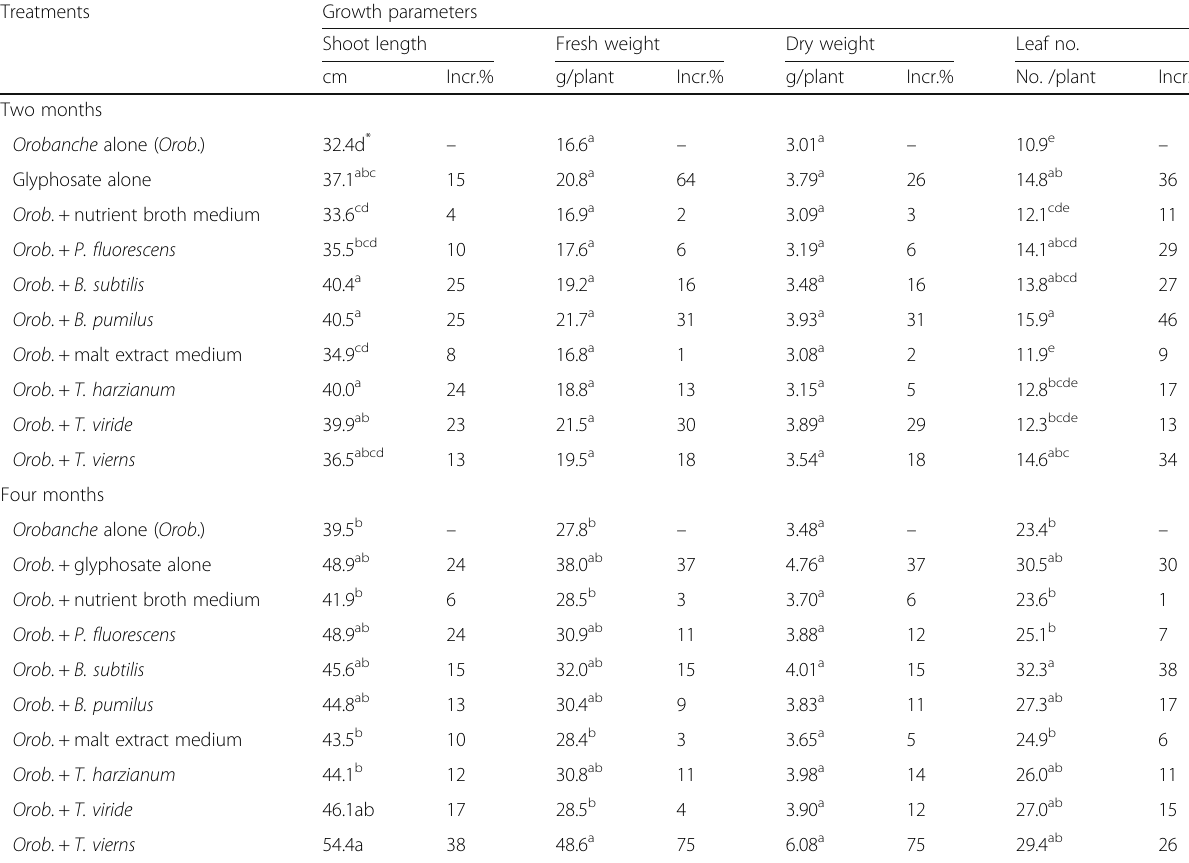
Table 3 Effects of plant growth-promoting bacteria and Trichoderma species on growth parameters of faba bean with O. crenata infection, under greenhouse conditions (Experiment II)